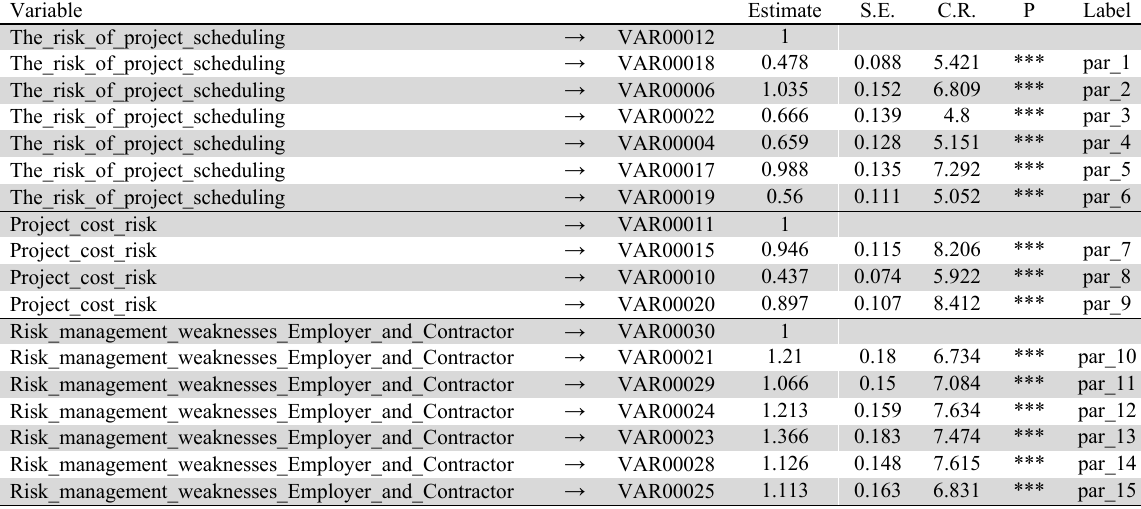
The results of comparison of details of the fitting model Variable